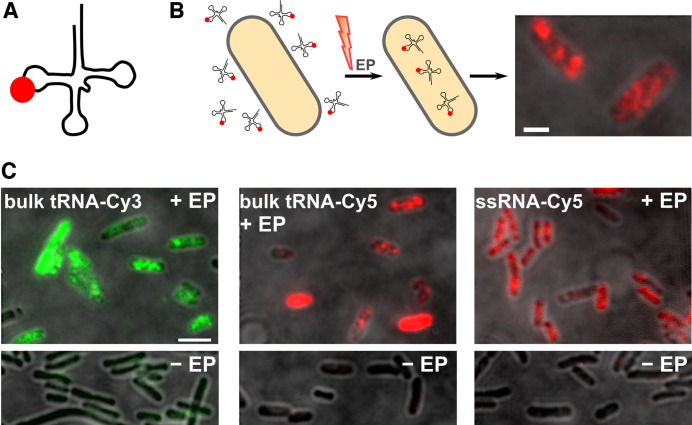
Internalization of labeled tRNA molecules into live Escherichia coli. (A) Schematic of labeled tRNA molecule. (B) Schematic of the internalization method using electroporation (EP). Labeled tRNA molecules are added to cell suspension of electrocompetent cells and are exposed to the discharge of a high-voltage electric field. Cells are quickly recovered and non-internalized tRNA molecules are washed off. Cell imaging is performed on an inverted microscope using HiLO illumination. Scale bar: 1 μm. (C) Efficient loading of E. coli cells with tRNAs labeled with organic fluorophores of different spectral range. Cells show high inner-cell fluorescence upon electroporation with 1 μM of tRNA-Cy3, tRNA-Cy5, and ssRNA-Cy5 (top row, left to right) and basal fluorescence of non-electroporated cells corresponding to cellular autofluorescence in the respective spectral channel (‘−EP’ cells, bottom row). More than 85% of cells were loaded when internalizing tRNA-Cy3, tRNA-Cy5 and ssRNA-Cy5 (>500 cells per dataset). Scale bar: 3 μm.